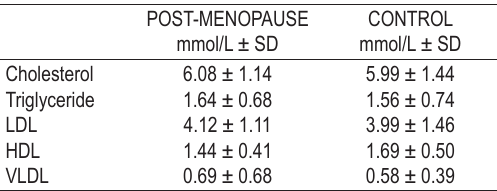
TABLE 1. Total values of cholesterol, triglyceride, LDL, HDL and VLDL levels in blood of post-menopausal and control group of pre-menopausal women.